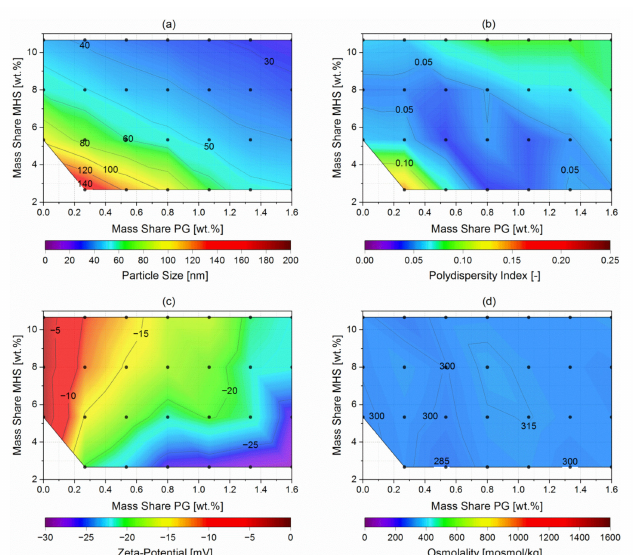
Figure 3. Contour plots showing ( a ) the resulting particle diameter, ( b ) the PDI, ( c ) the zeta potential in 0.1 × PBS at pH 7.4, and ( d ) the osmolality of the screening trials depending on the MHS against the PG mass shares at a constant MCT mass share of 8 wt.%, in which each dot • represents a conducted